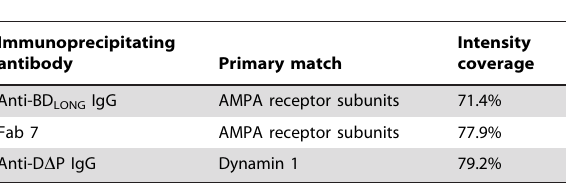
Table 1. MALDI-TOF mass spectrometric peptide fingerprint analysis of the 100-kDa protein band present in the immunoprecipitates.